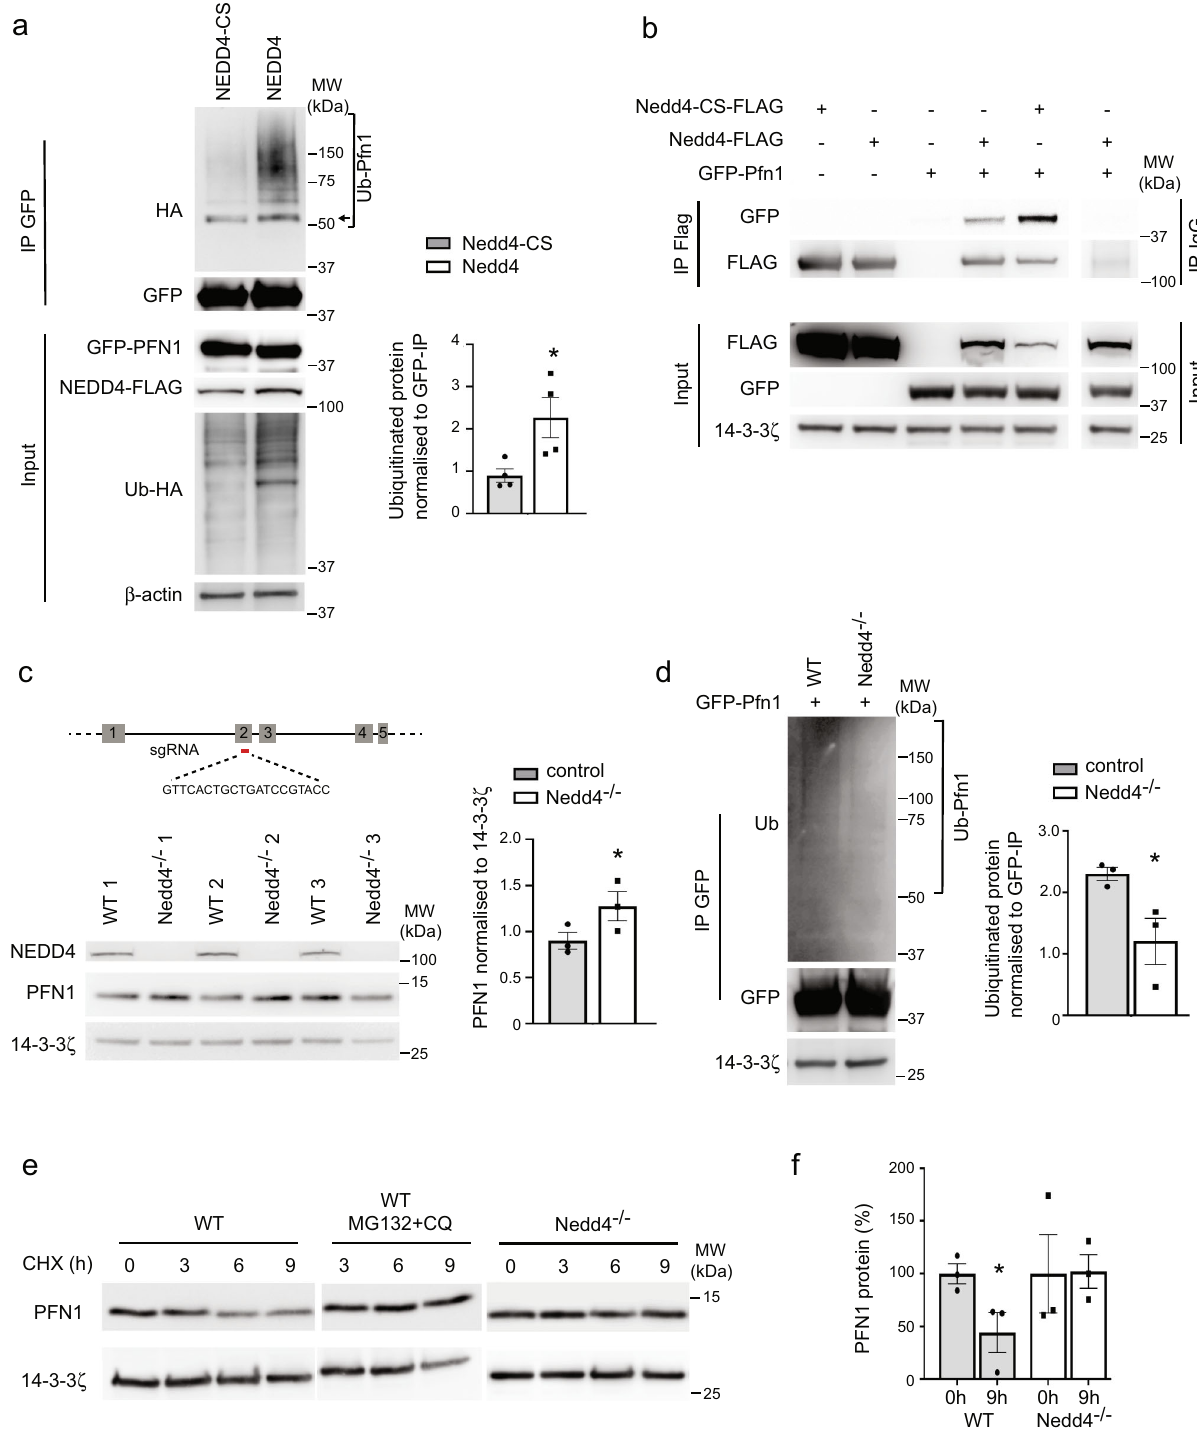
fi lamentous actin from monomeric G-actin we next quantitated the levels of G- and F-actin in NCCs. As expected, Nedd4 − / − NCCs had an increased ratio of F:G actin compared to controls at steady-state levels (Fig. 7e). The ratio of F:G actin was also quanti fi ed in the Cyto D washout experiment. After CytoD treatment (0 min) the ratio of F:G actin was similar between control and Nedd4 − / − NCCs (Fig. 7f). Consistent with our ima- ging analysis, after 180 min recovery there was a signi fi cant increase in the ratio of F:G actin in Nedd4 − / − NCCs compared to NATURE COMMUNICATIONS| (2022) 13:2018